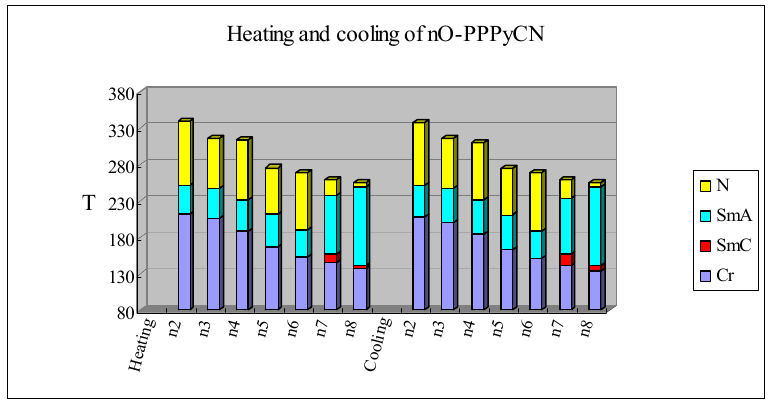
Figure 2. Plot of transition temperatures of heating and cooling cycle for compounds